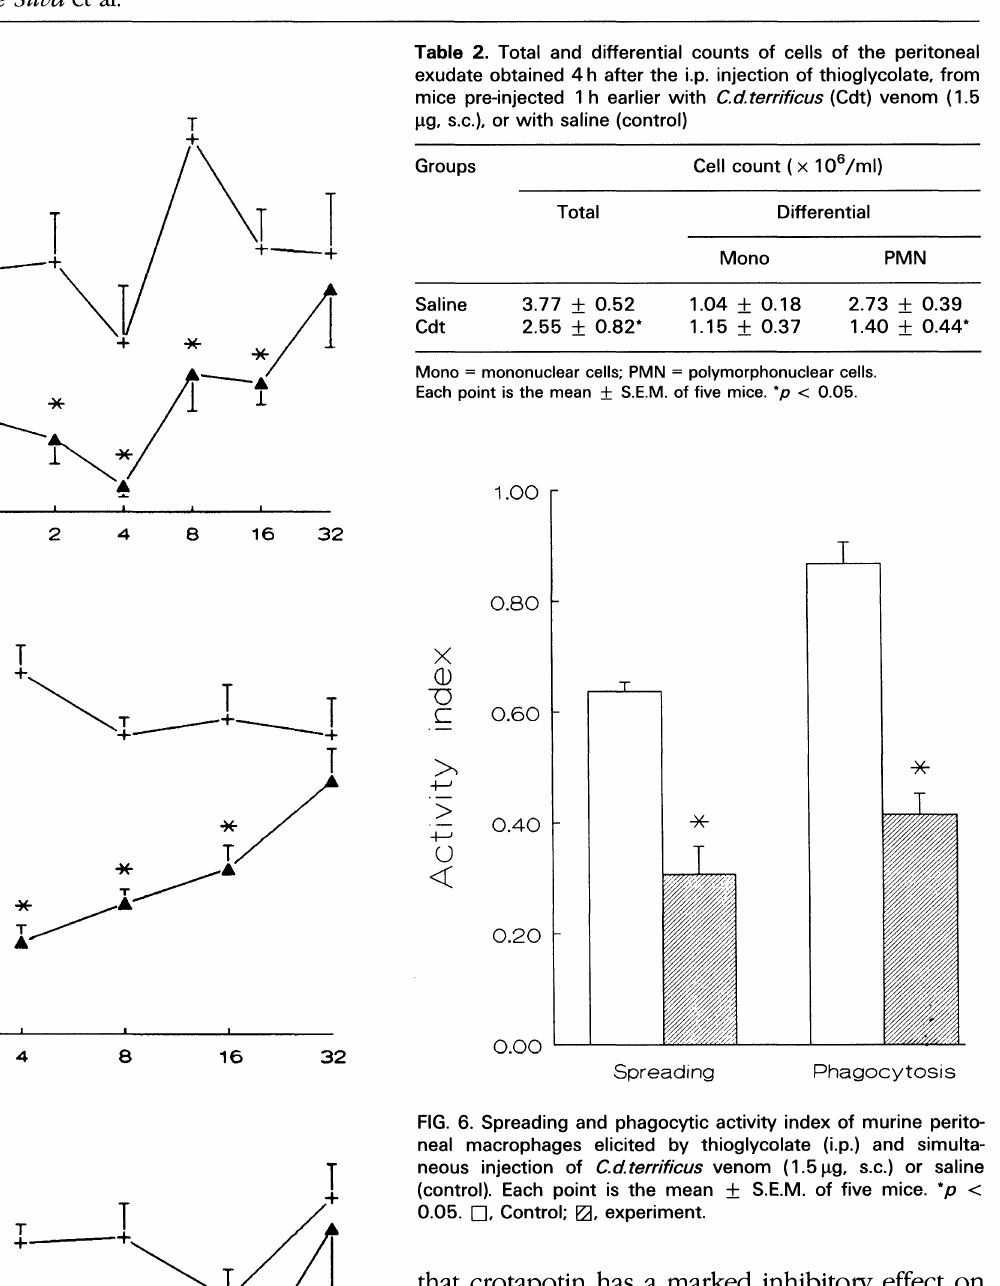
FIG. 6. Spreading and phagocytic activity index of murine perito- neal macrophages elicited by thioglycolate (i.p.) and simulta- neous injection of C.d.terrificus venom (1.51g, s.c.) or saline (control). Each point is the mean -!- S.E.M. of five mice. *p < 0.05. r-I, Control; 17-/I,